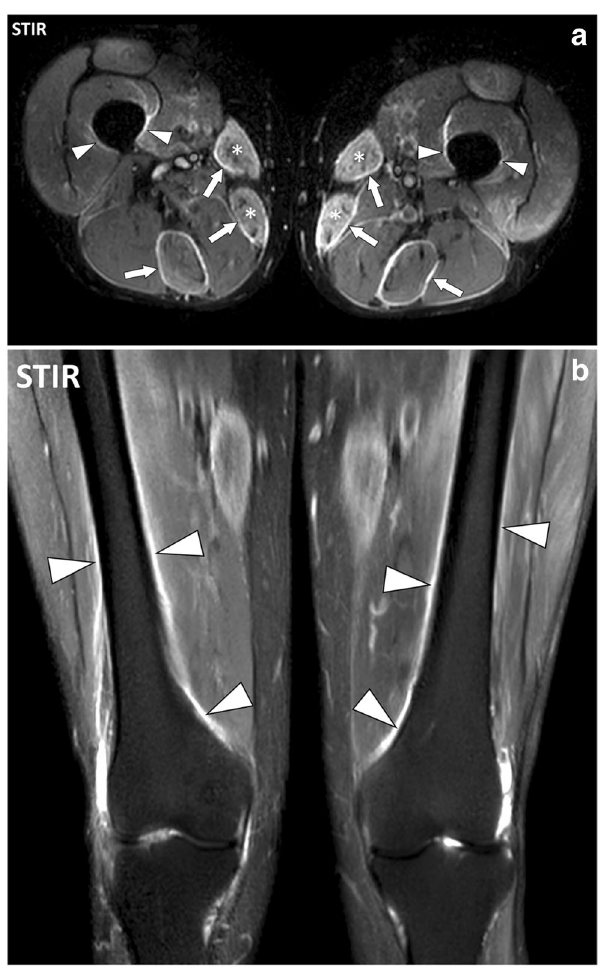
Fig. 18 a Axial and ( b ) coronal STIR images of the thighs of a 51-year- old male with polymyositis. MRI demonstrates bilateral symmetrical in- volvement with myositis of the sartorius and gracilis muscles (asterisks), fasciitis of the deep fasciae adjacent to sartorius, gracilis and semitendinosus muscles (arrows)and periostitismostlyon themedial part of the diaphysis and metaphysis of the femurs